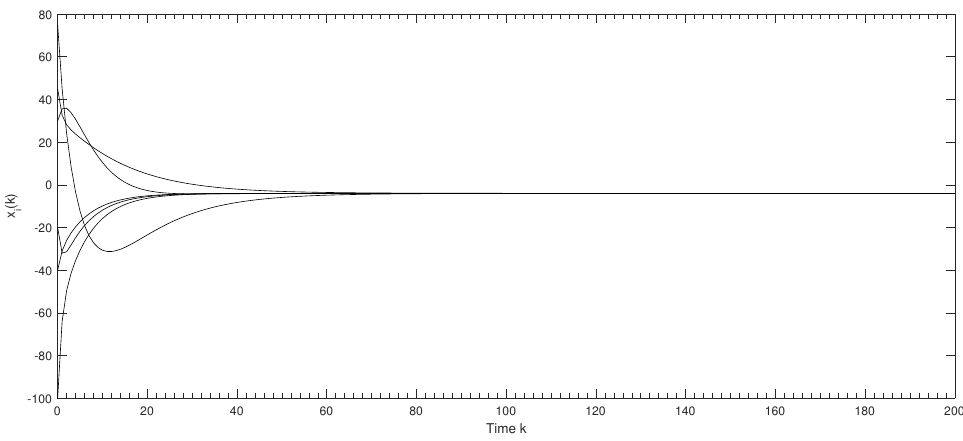
Figure 3. State trajectories of six agents for h =